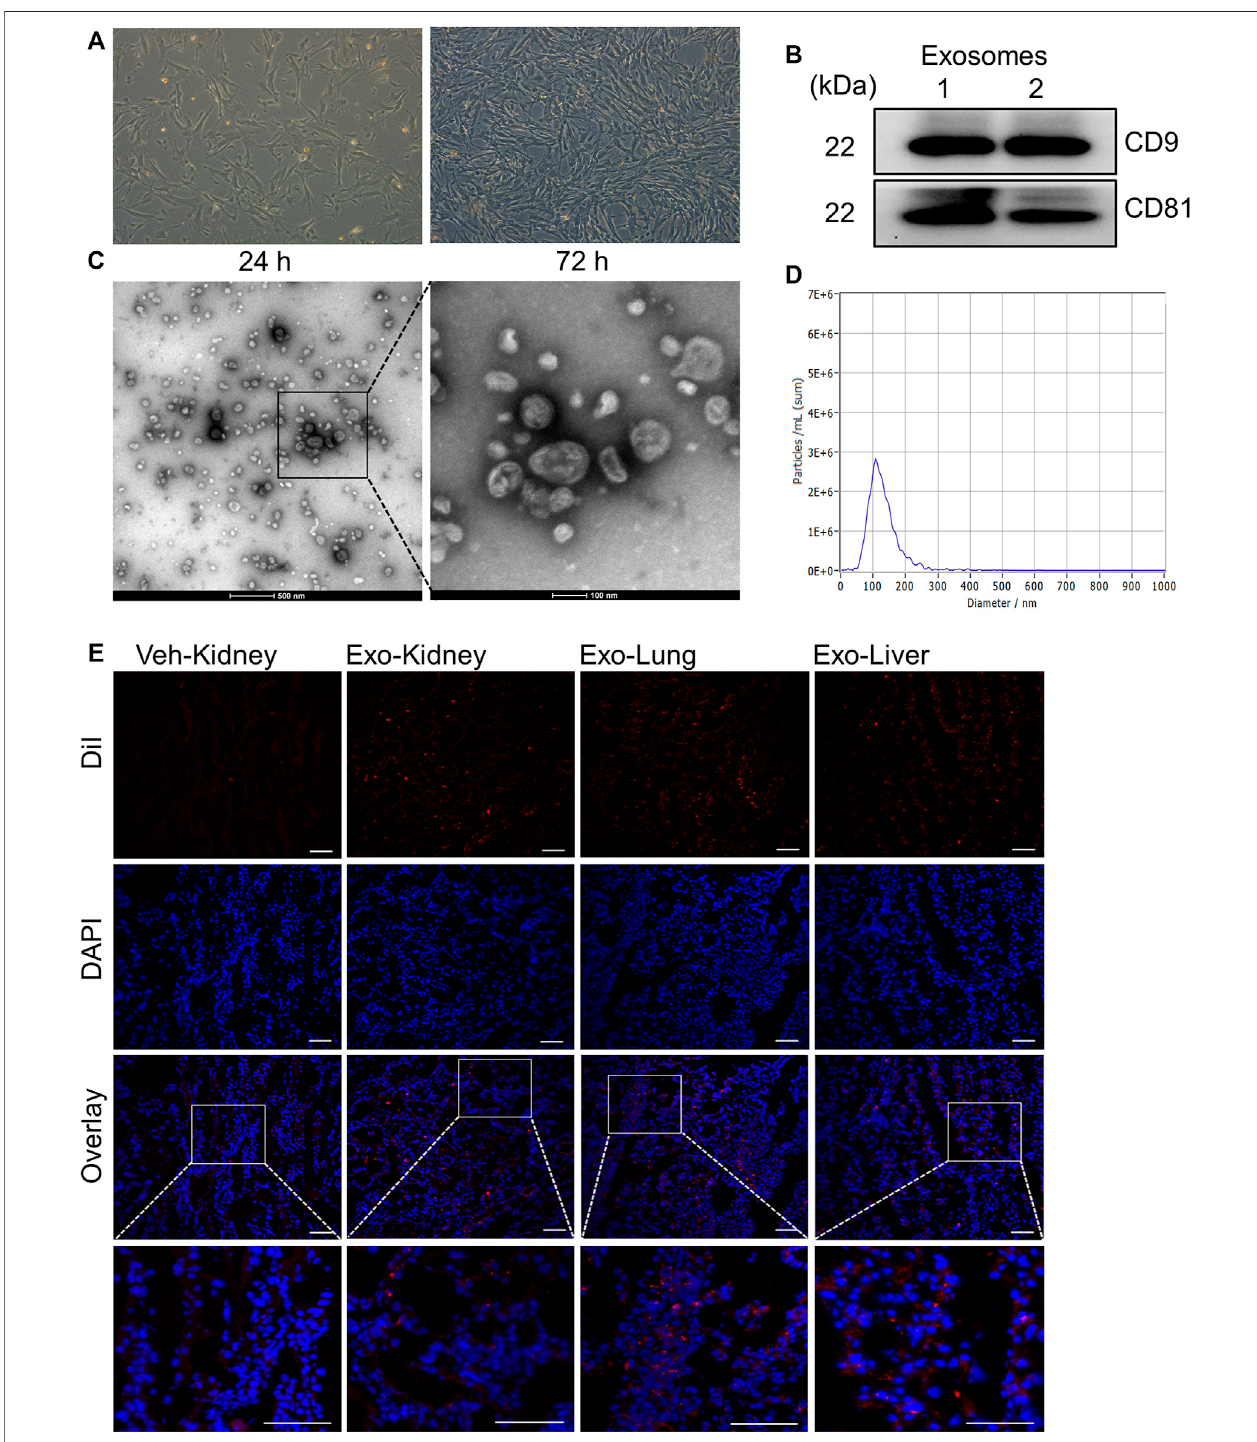
FIGURE 3 | Extraction and identi fi cation of exosomes from mesenchymal stem cells derived from human umbilical cord. (A) Pictures of the 6th passage of mesenchymal stem cells after 24 and 72 h of culture. Scale bar = 100 µm. (B) The expression of the marker molecules CD9 and CD81 in the exosome lysate was detected by immunoblotting. Two samples from different extraction batches was tested. (C) Morphology of exosomes observed under transmission electron microscope. (D) The particle size distribution of exosomes by Nanoparticle Tracking Analysis. (E) Biodistribution of exosomes labeled by DiI in different organs. Scale bar = 100